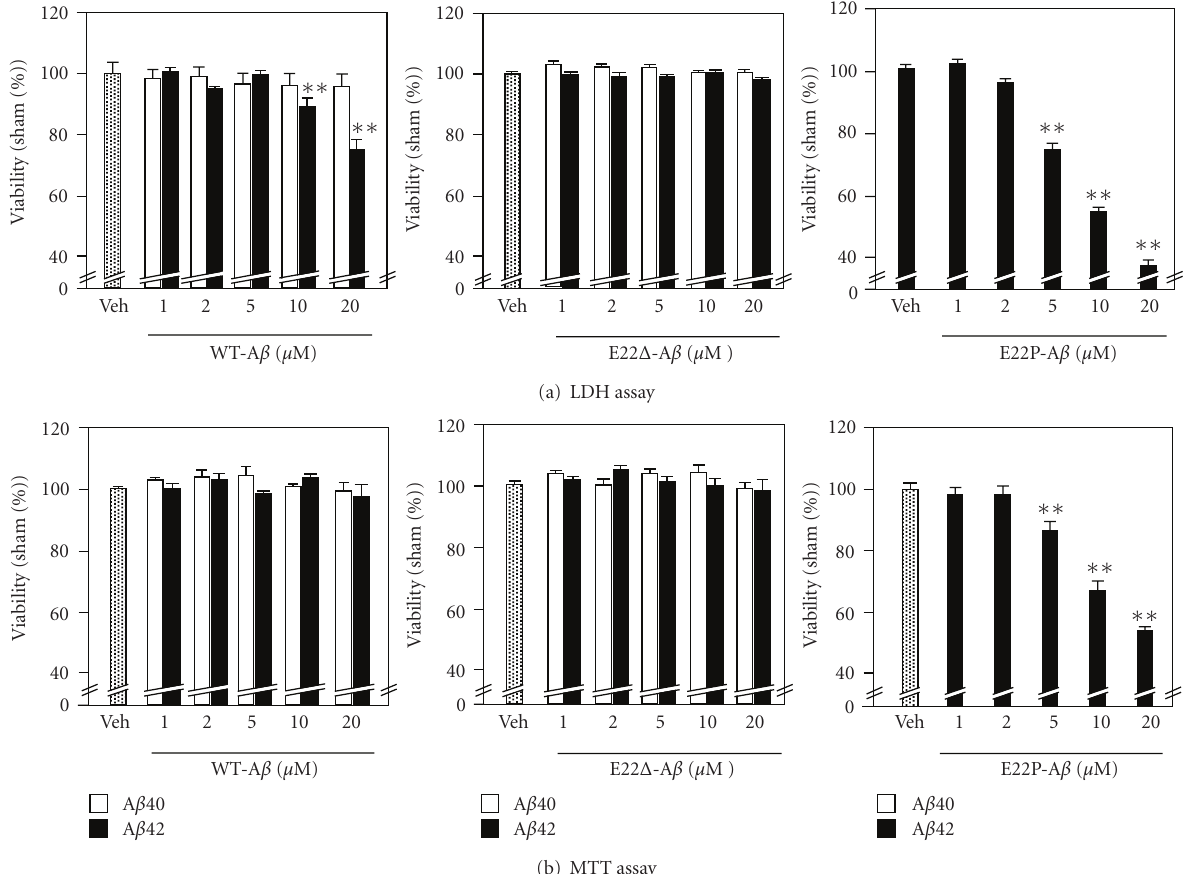
Figure 4: Neurotoxicity of A β 40, A β 42, E22 Δ -A β 40, E22 Δ -A β 42, and E22P-A β 42 with the indicated concentration (1, 2, 5, 10, and 20 μ M) using primary rat cortical neuronal cell cultures after 48-hr incubation at 37 ◦ C. Data are expressed as the mean ± s.e.m. ∗ P < . 05 versus vehicle, ∗∗ P < . 01 versus vehicle. Veh: